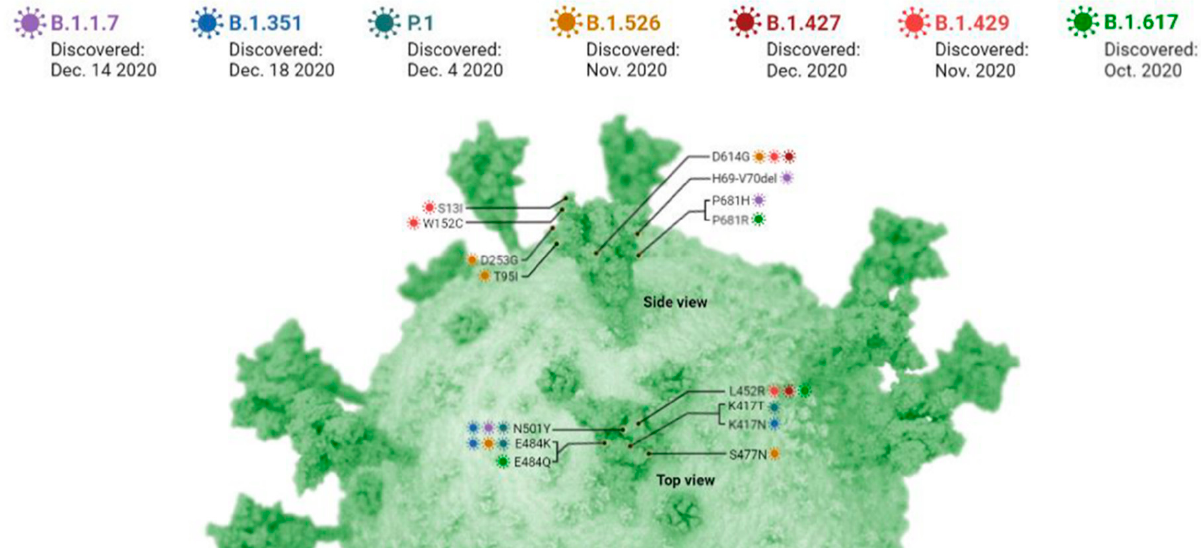
Figure 1. A snapshot of the rising variation in the strains of the SARS-CoV-2 due to mutations.